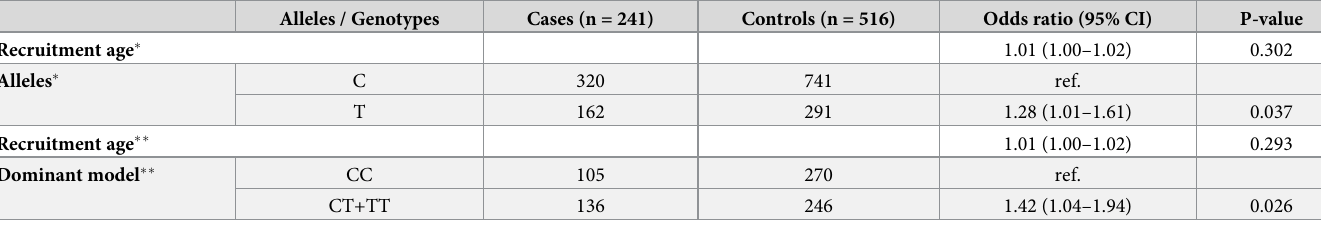
Table 2. Logistic regression model analysis of ITGAM